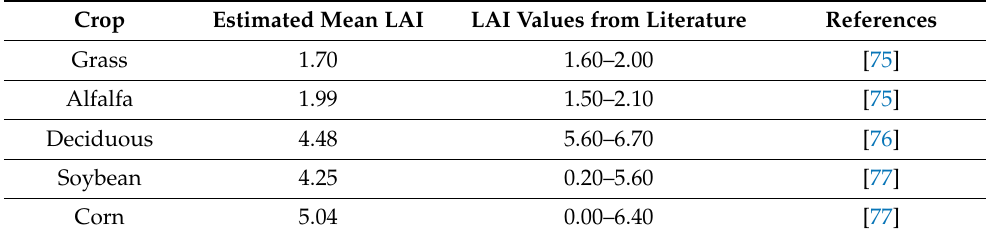
Figure 6. Estimated leaf area index (LAI) for each key crop (10-day averaged values) during the 2018 growing season.